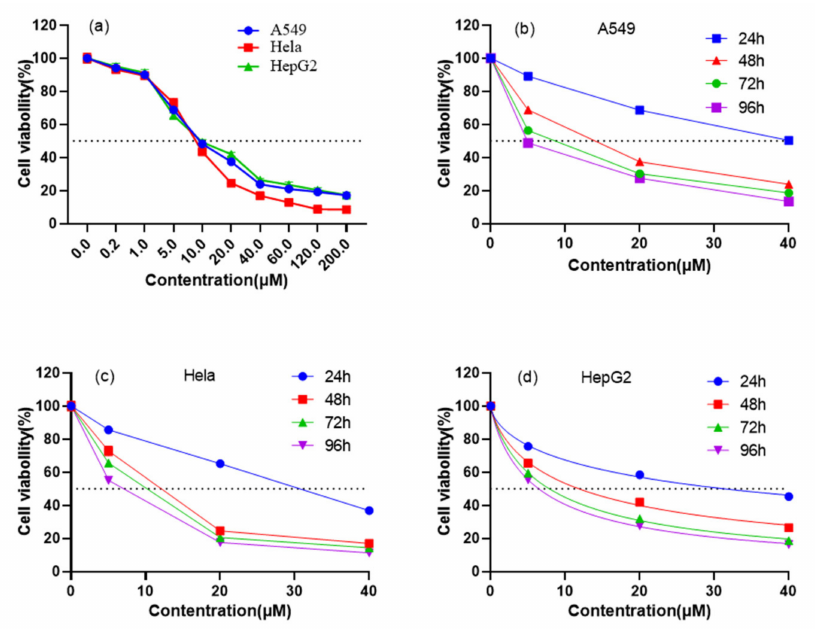
Figure 8. ( a ) Effects of complex 1 on HepG2, HeLa, and A549 cell viability and proliferation after 48 h exposure. ( b – d ) Time course of effects of complex 1 on A549, HeLa, and HepG2 cell viability and proliferation.